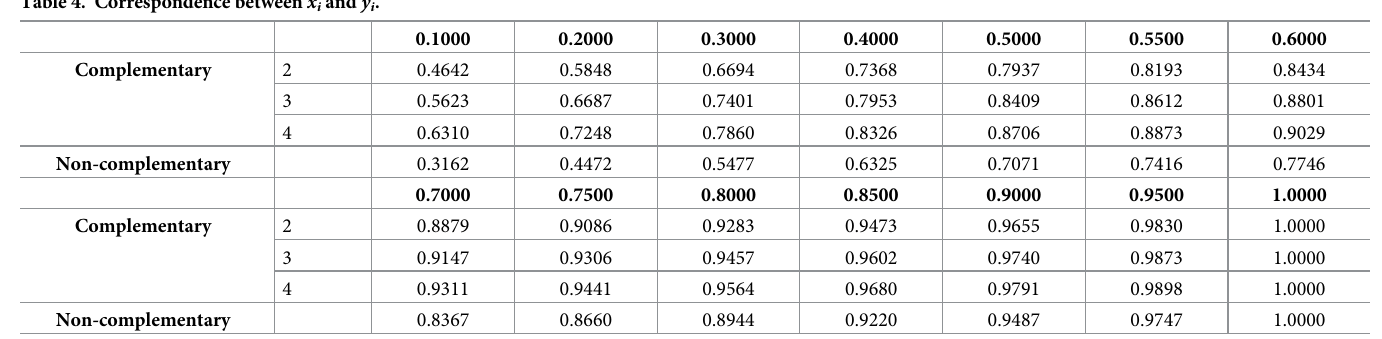
Table 4. Correspondence between x i and y i